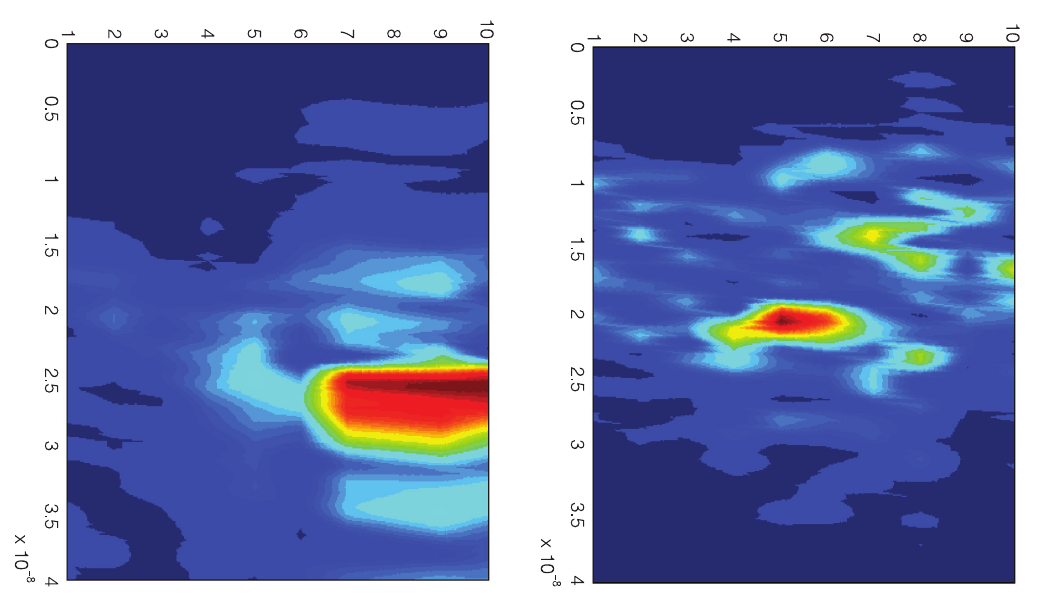
Fig. 6. Image of a metal pipe at 80 cm of depth in ungated mode. Linear common offset (distance be- tween the gaps of 55 cm). Diameter of the pipe of 80 cm. Frequency band of 200-800 MHz. Frequency step of 2 MHz. The abscissa is the number of scan with spatial step 20 cm. The ordinate is the return time in